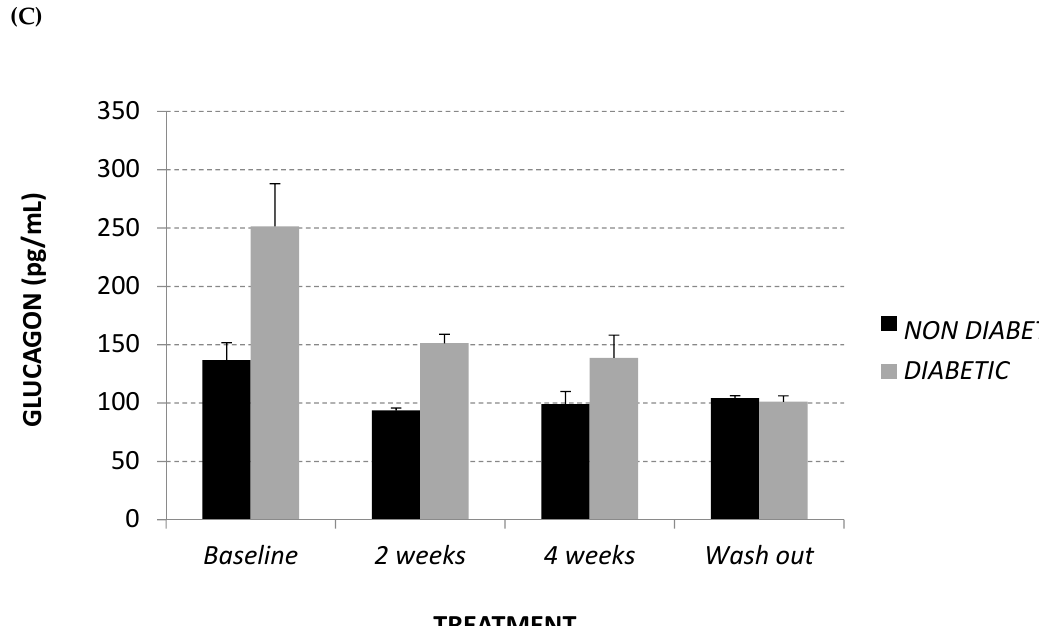
Figure 2. Intravenous glucose tolerance test (area under curve: AUC) ( A ), glucose stimulated insulin secretion test (AUC) ( B ) and fasting glucagon (pg/mL) ( C ) at baseline, after 2 and 4 weeks of Afriplex GRT treatment, and following 4 weeks wash-out in non-diabetic (black) and diabetic (grey) vervet monkeys. * p < 0.05, ** p < 0.01 comparing different experimental time points for each group; # p < 0.05 comparing both population groups for the same experimental time point. a = baseline, b = 2 weeks-treatment.